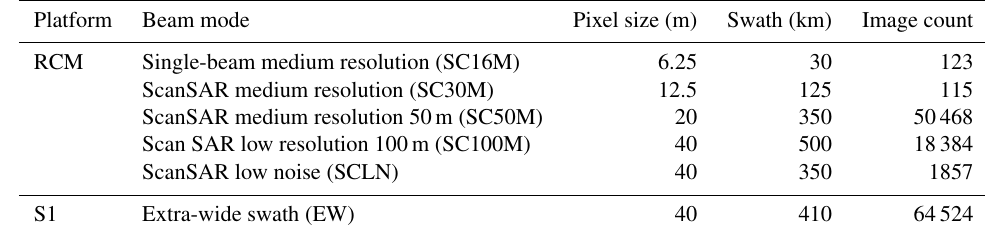
Table 1. Satellite SAR image inventory used in this analysis from March 2020 to October 2021.